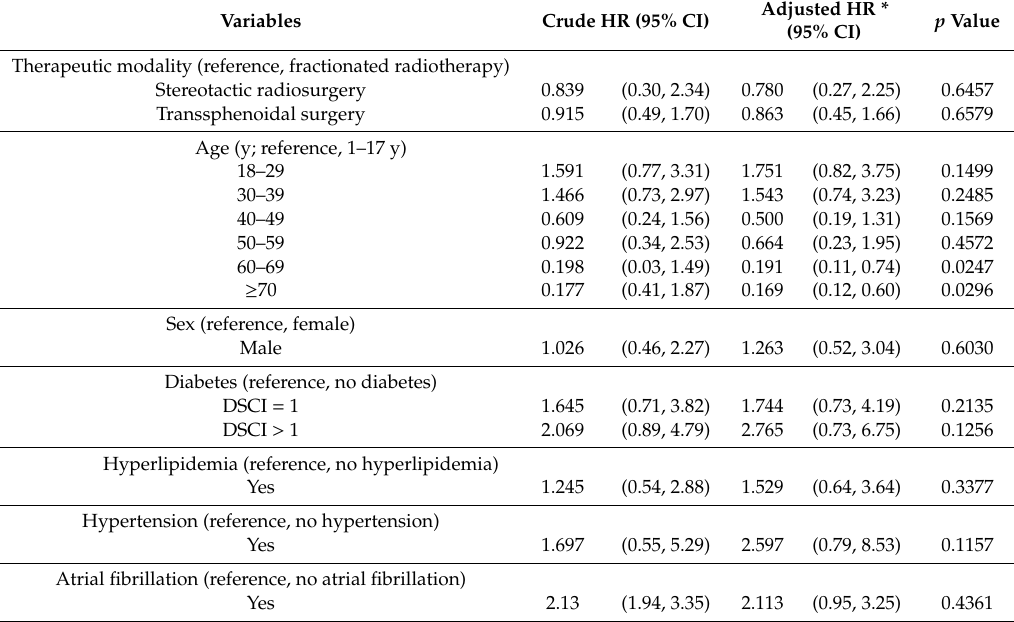
Table 3. Cox proportional hazards regression analysis of hypopituitarism risk in patients with nonfunctioning pituitary macroadenomas who received di ff erent treatments.